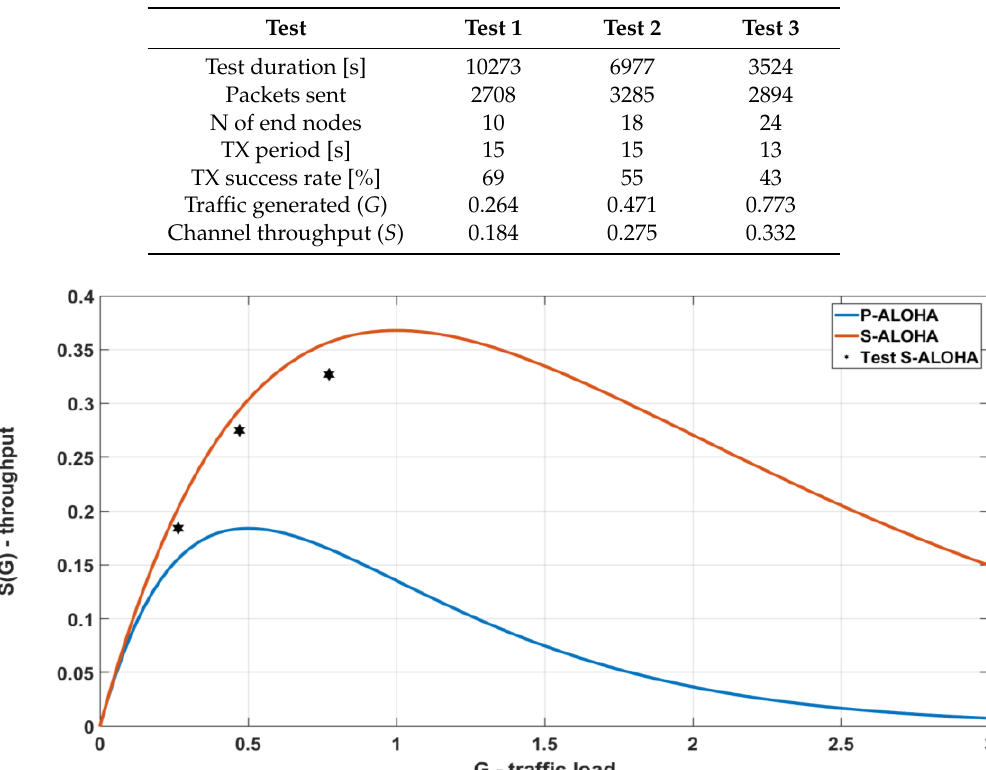
Table 2. Summary of the results obtained from the tests with Slotted LoRaWAN.